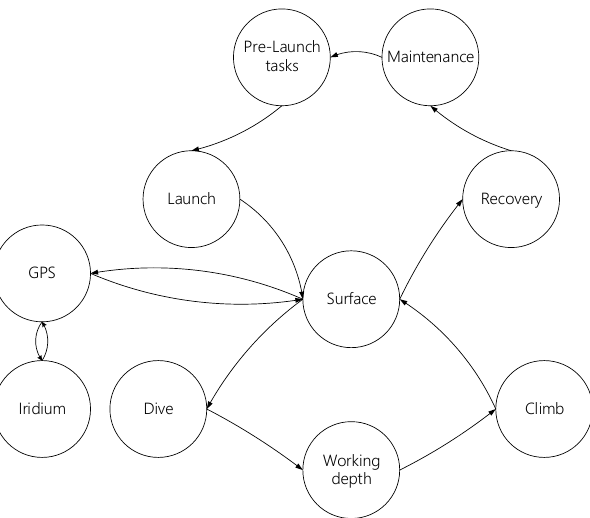
Figure 15. Sequential description of a